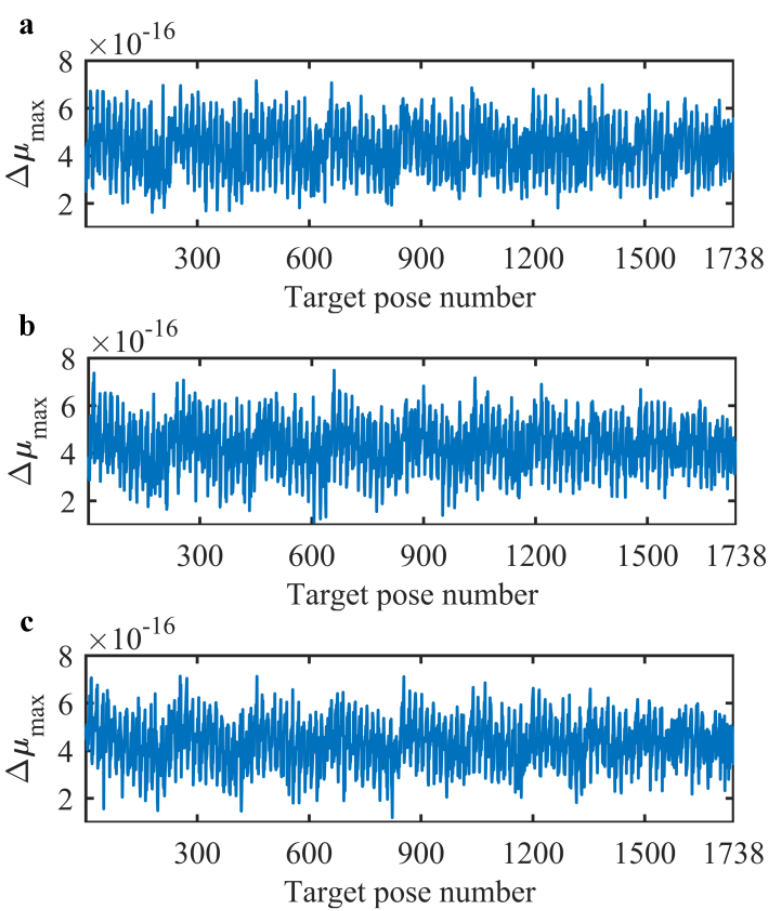
Table 8. Standard deviations of the geometric errors for the numerical simulations.